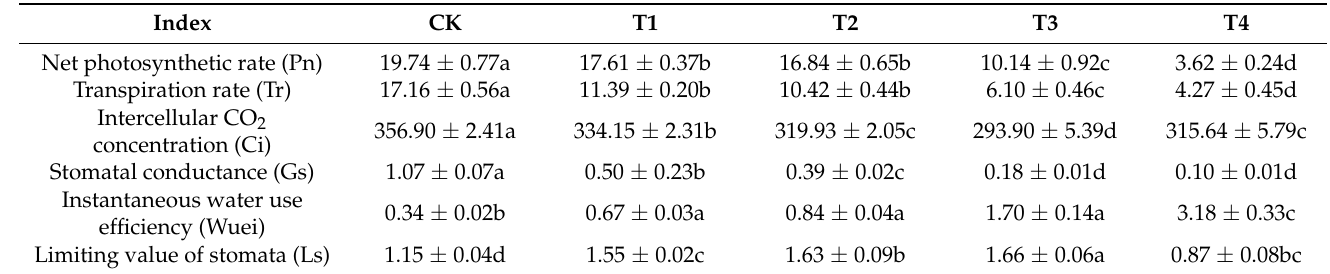
Table 2. Effects of water stress on gas exchange parameters of Glycyrrhiza uralensis . Different lowercase letters indicate a significant difference at a 5% level between different times.